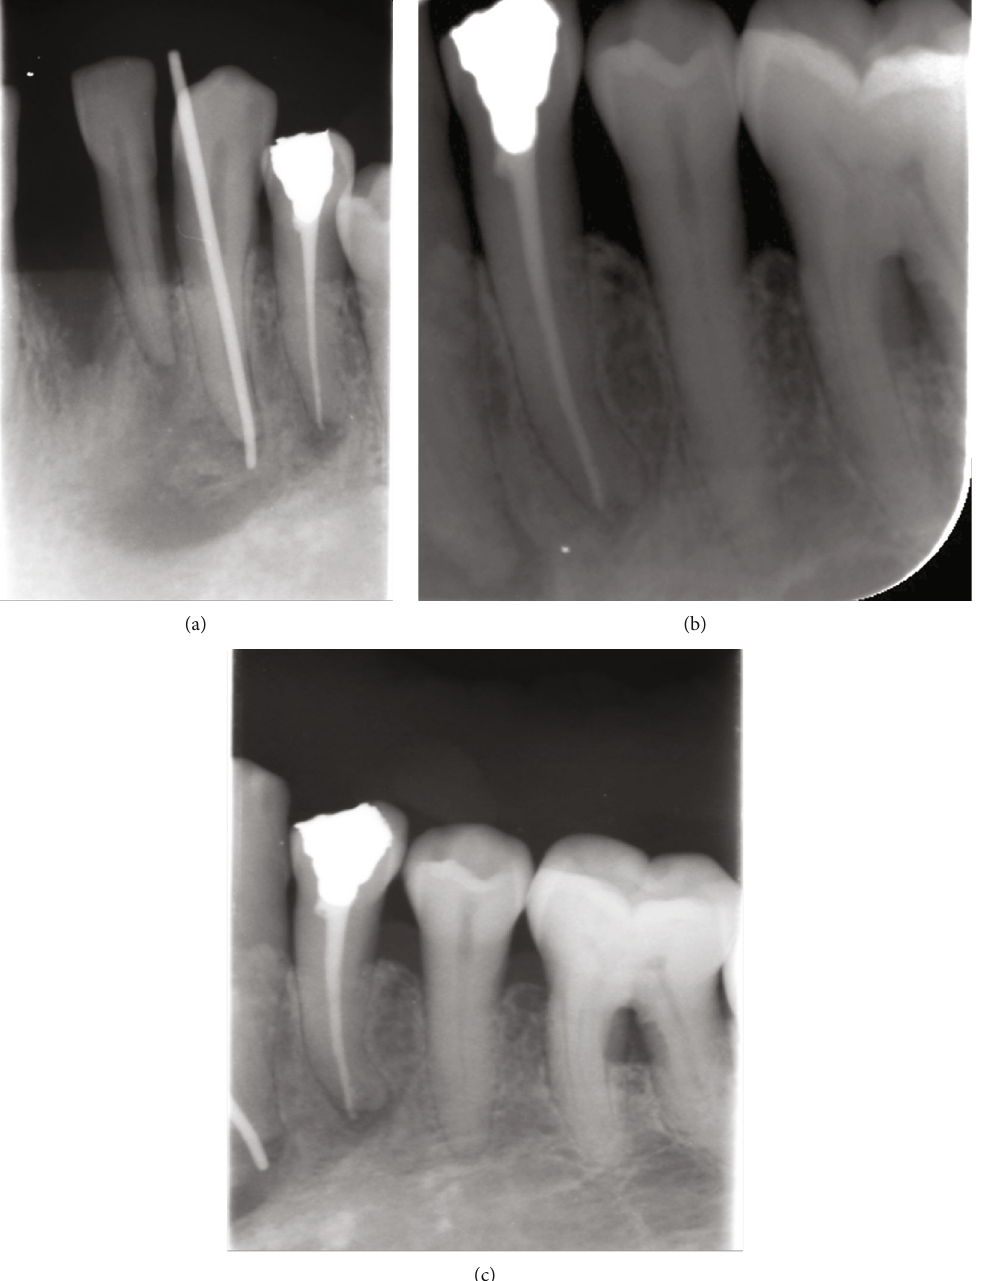
Figure 2: Intraoral preoperative periapical radiograph showing an irregular periapical radiolucency involving both #33 and #34. (a) Tracing was made using gutta-percha point done. (b, c) Other periapical